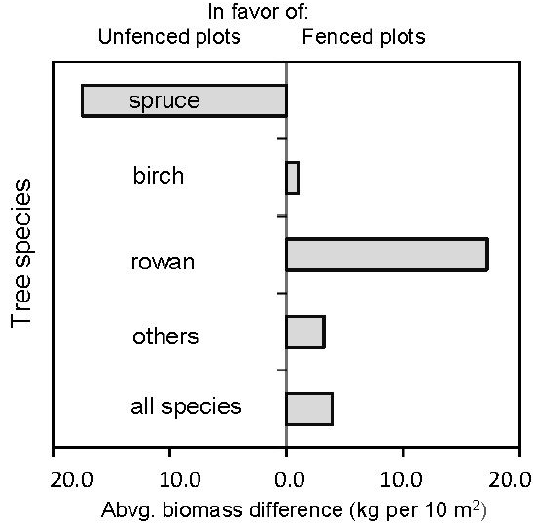
Table 5. A comparison of mean values, standard errors, and coefficients of variability for Gini, Clark–Evans, and Shannon index between the plots within unfenced (open to herbivores) and fenced (herbivore exclusion) plots. Gini H index (indi- cates height evenness in stand—the higher value the higher evenness, Clark–Evans index (indicates space distribution of